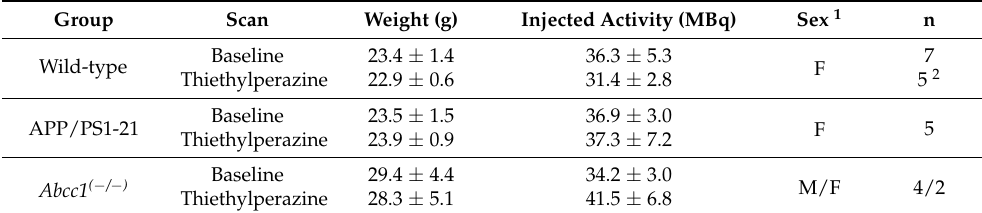
Table 1. Overview of the animal groups included in the study. The animals received a baseline scan and a scan after a 5-day oral treatment period with thiethylperazine (15 mg/kg, once daily).